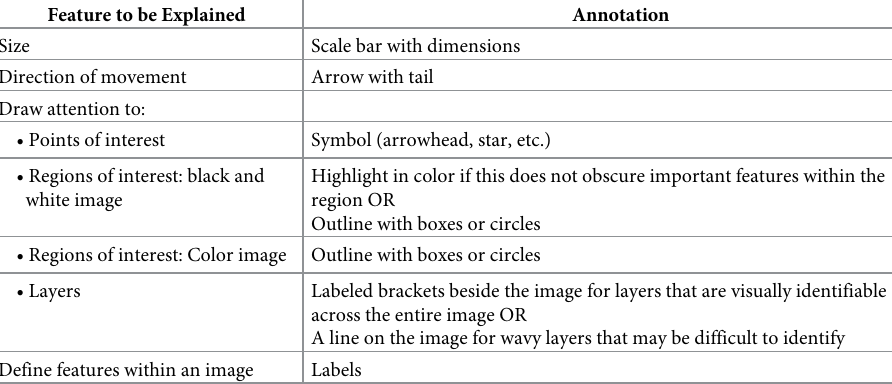
Table 1. Use annotations to make figures accessible to a broad